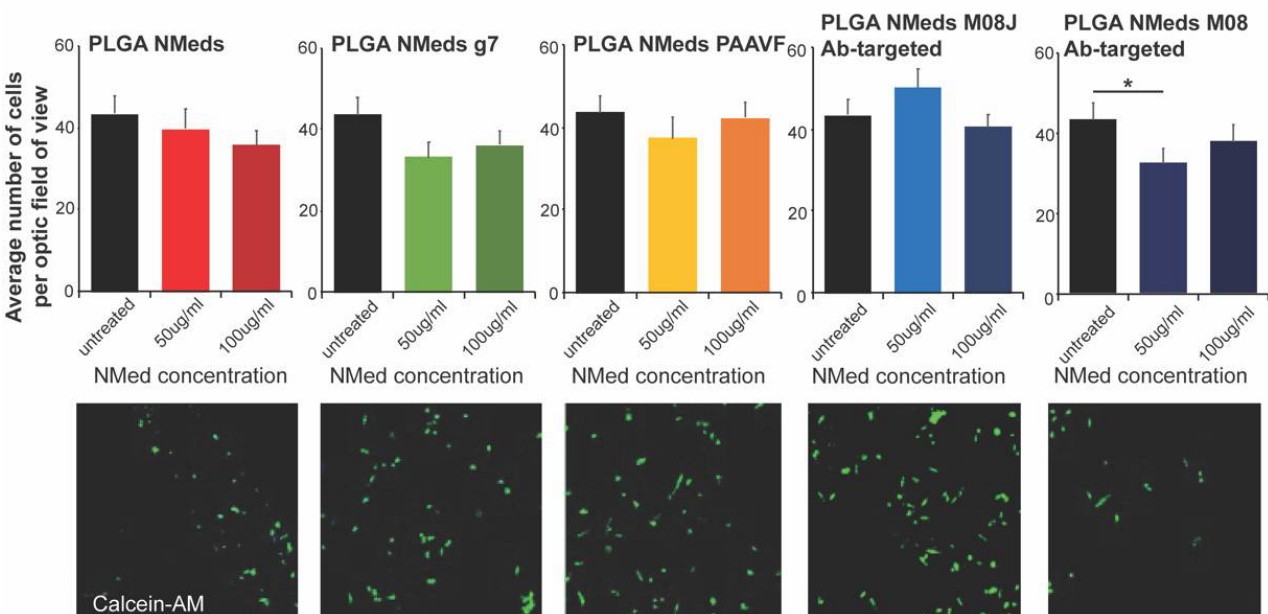
Figure 3. Cell growth inhibition studies. Quantification ( top ) of the number of cells per field analysed after incubating NMeds at a concentration of 50 or 100 μg/mL for 3 h and visualised by confocal microscopy ( bottom ). The number of cells visualised by DAPI and Calcein-AM staining per optic fields of view (OFV) was measured by counting n = 10 OFV for each condition. Statistical analysis was performed with one-way ANOVA and Post hoc analysis, * p < 0.05.